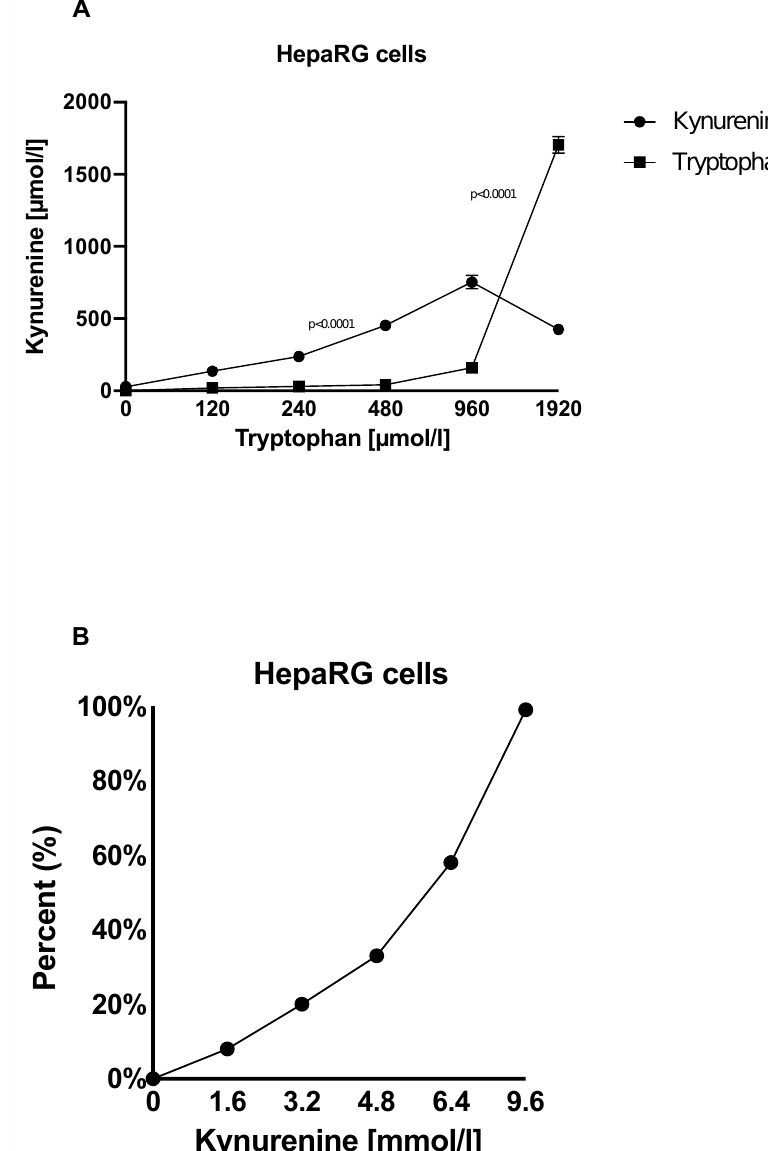
Figure 3. ( A ) Kyn accumulation and Trp degradation for different concentration levels of Trp in HepaRG cells. ( B ) The Trp to Kyn ratio increases as higher levels of kynurenine suppress Trp degradation. ( C ) The percentage of Trp degradation in HepaRG cells cultured in 480 µ M Trp and various concentrations of Kyn for 72 h.